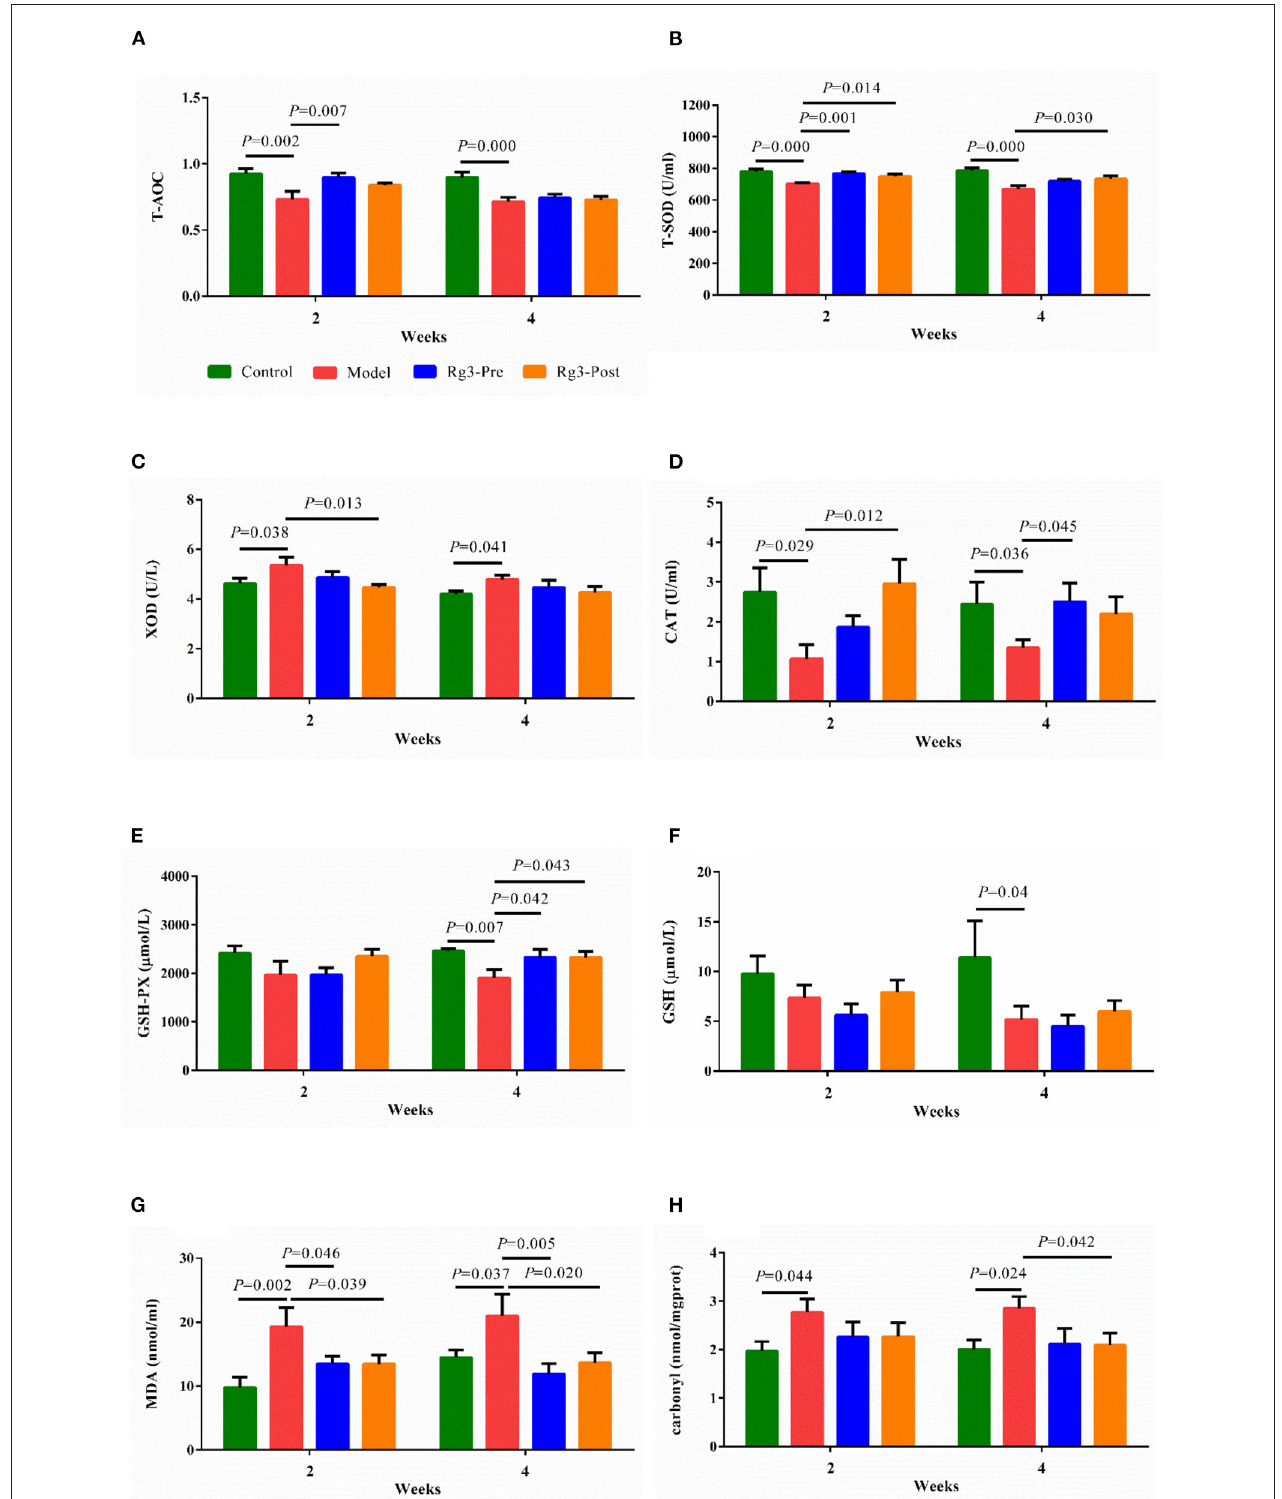
FIGURE 4 | Effect of ginsenoside Rg3 on enzymatic antioxidants and non-enzymatic antioxidants in broilers with stress. Detection for serum total antioxidant capacity (T-AOC) (A) , total superoxide dismutase (T-SOD) (B) , xanthine oxidase (XOD) (C) , catalase (CAT) (D) , glutathione peroxidase (GSH-PX) (E) , glutathione (GSH) (F) , malondialdehyde (MDA), (G) and carbonyl (H) . Values are means ± SE ( n = 10).